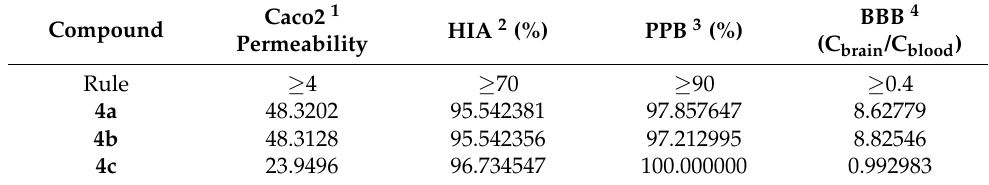
Table 2. Prediction of pharmacokinetic properties of the synthesized compounds. Caco2 Compound